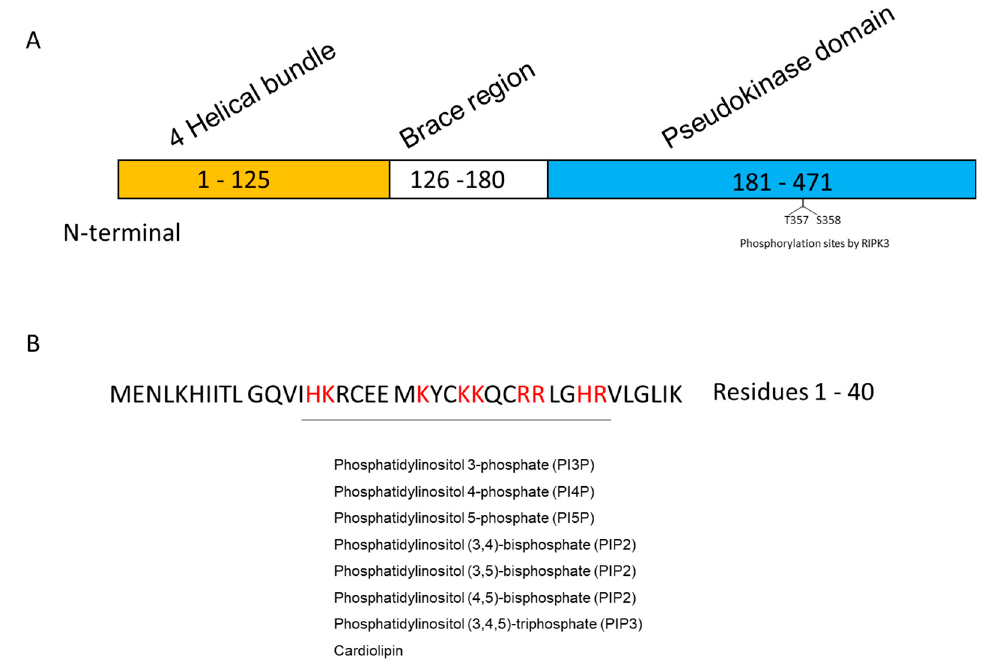
Figure 1. MLKL structure and phospholipid-binding region. ( A ) Domains of human MLKL; ( B ) Amino acids (red) responsible for binding to phospholipids. MLKL, mixed lineage kinase domain- like protein.